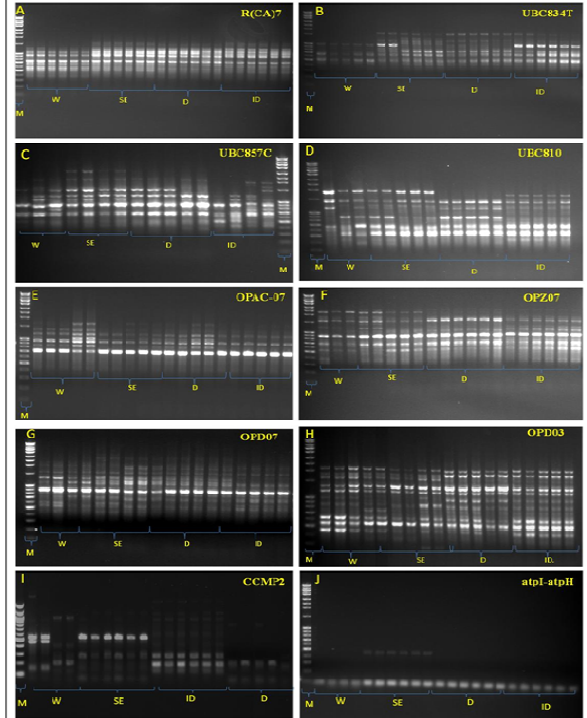
Fig. 3. Gel profiling of wild= W, in vitro regenerated plants through somatic embryogenesis (SE), direct organogenesis(D), indirect organogenesis (ID) using ISSR analysis (A-D), RAPD